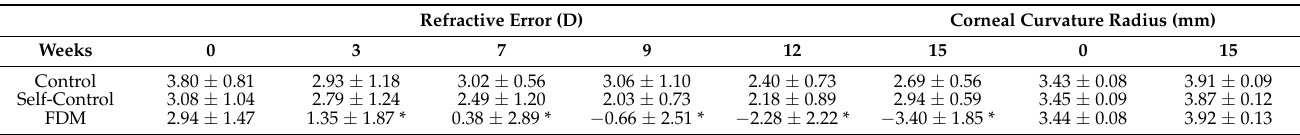
Table 2. The change of refractive error and corneal curvature in different groups during the course of the study ( n = 12/group).